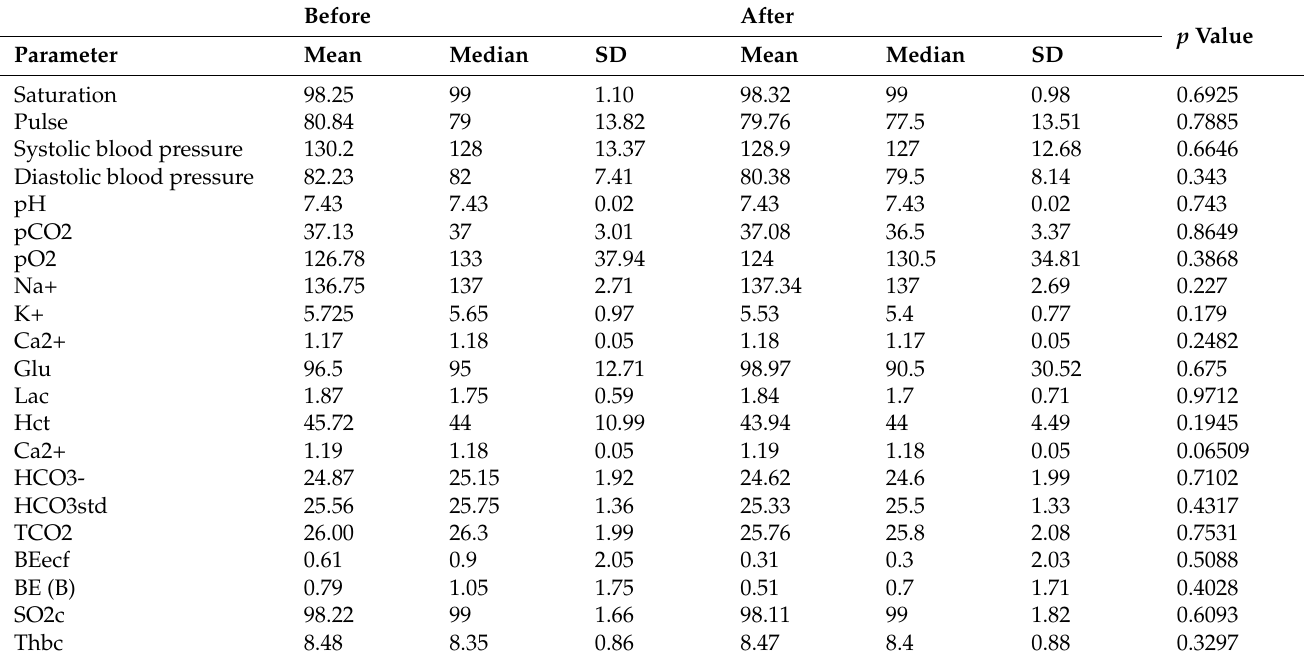
Table 7. Results of the blood gas analysis and basic parameters of the FFP3 mask using the Wilcoxon signed-rank test. A p value < 0.05 was considered statistically significant. Statistically significant results are shown in